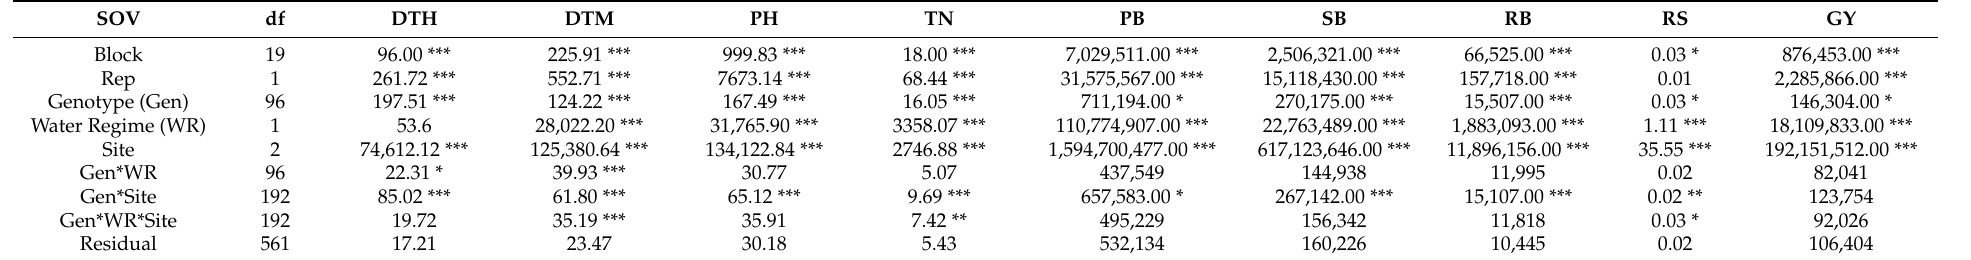
Table 2. Mean square values and significant tests after combined analysis of variance of biomass and yield-related traits of 97 wheat genotypes evaluated under non-stressed and drought-stressed conditions.